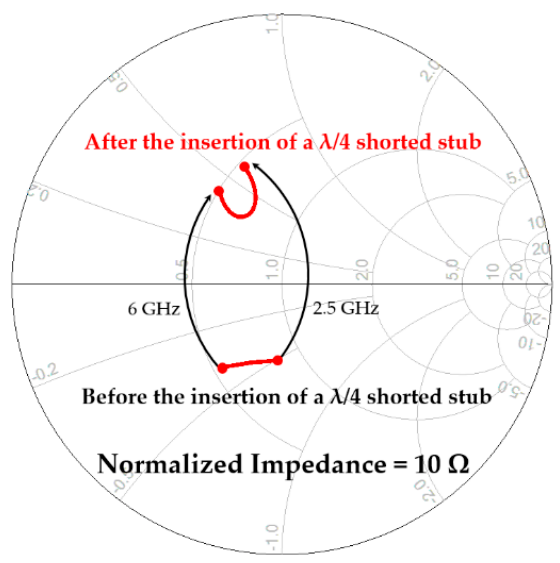
Figure 6. Variation of the transistor’s output impedance before and after the insertion of λ / 4 shorted stubs.